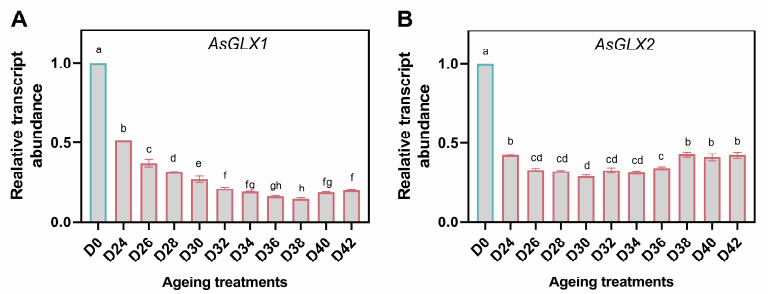
Figure 9. Relative expression levels of GSH-dependent glyoxalase genes, AsGLX1 ( A ) and AsGLX2 ( B ) in oat seeds. The letters represent statistical significance among the treatments, and the vertical bars represent the ±SEM at p < 0.05 level for three replicates. The mean values sharing the same letters are not different significantly, based on Duncan test.